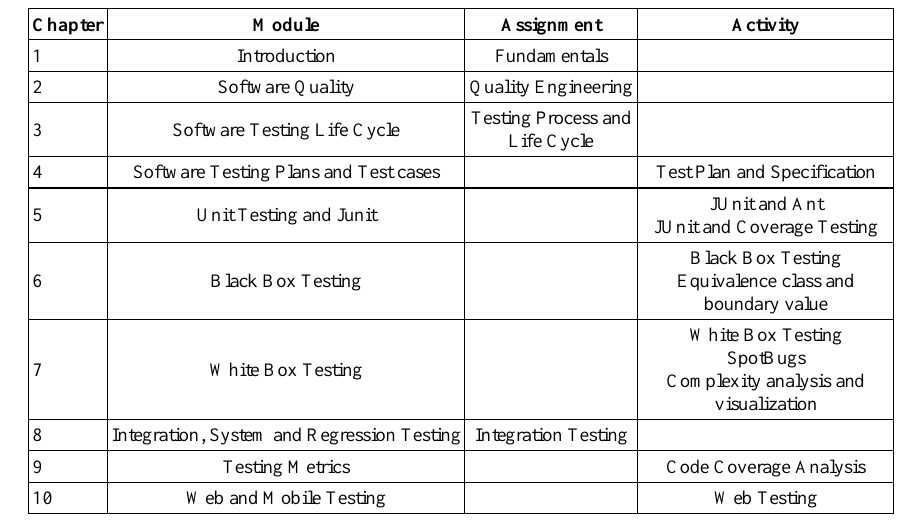
Table 1. Software testing course